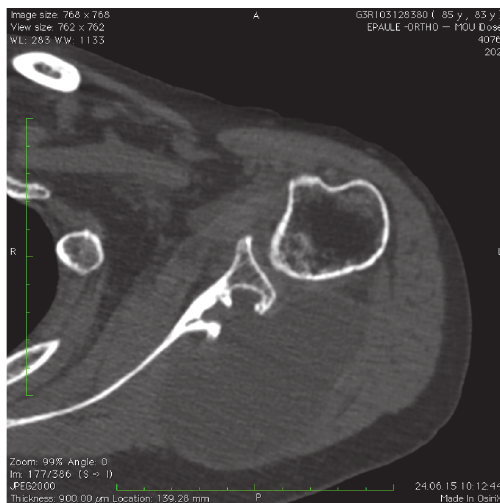
Figure 4: CT scan confirming the invasion of the scapula by the mass.